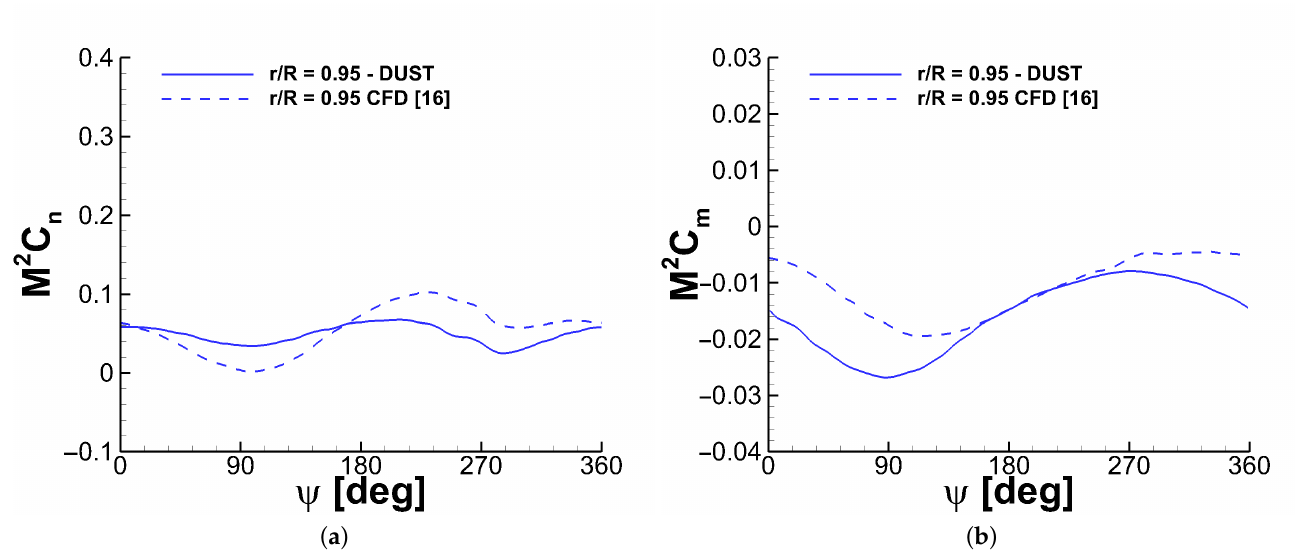
Figure 23. Comparison of the time histories of the non-dimensional normal force M 2 c n and pitching moment M 2 c m on the proprotor blade in conversion flight condition at r / R = 0.95, θ N = 30 ◦ , V ∞ = 140 kts, Ω = 589